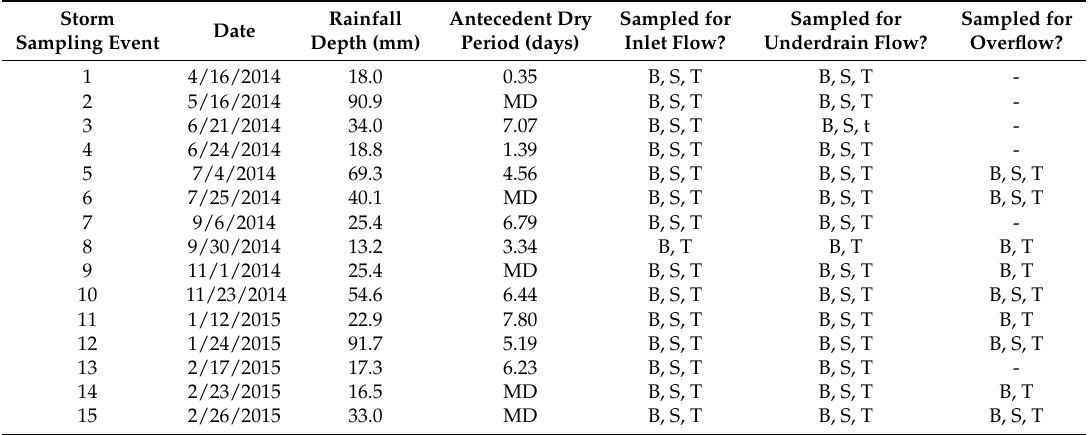
Table 3. Rainfall characteristics for each storm sampling